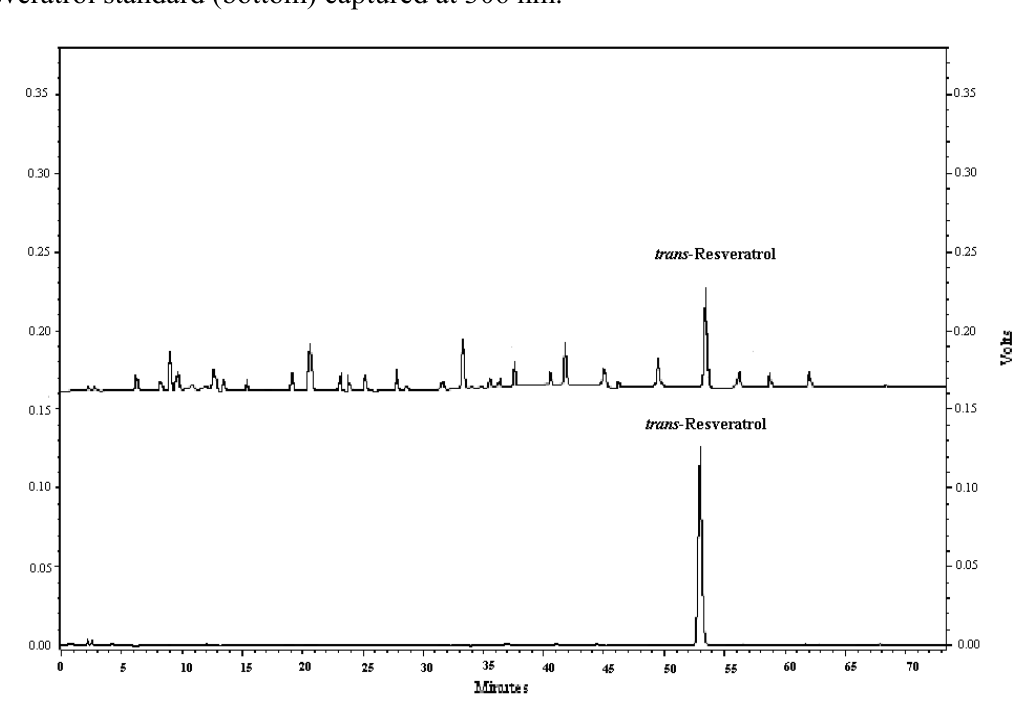
Figure 4. Typical HPLC chromatographies of grape cane extracts (top) and trans - resveratrol standard (bottom) captured at 306